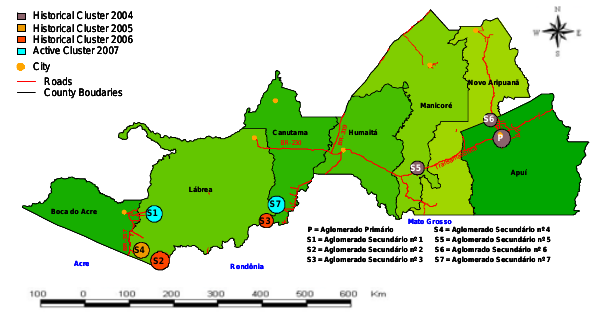
Figure 5. Retrospective analysis without use of co-variable distance from